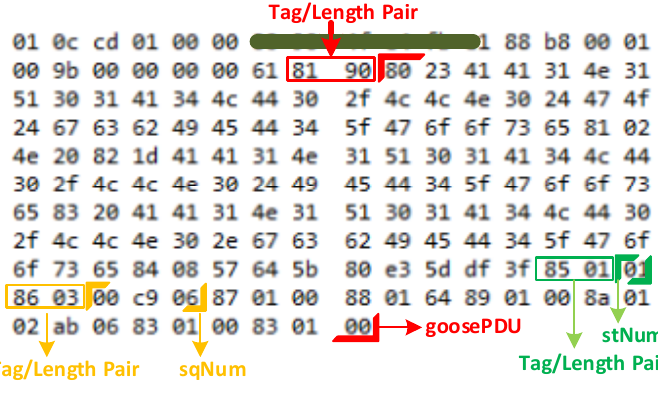
Figure 2. Hexadecimal Representation of a GOOSE Datagram.